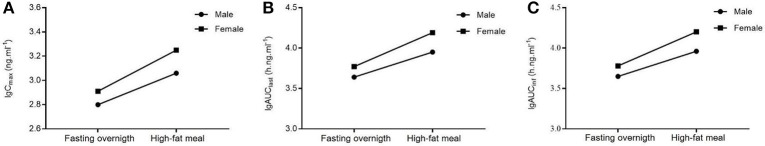
Interaction plots for Cmax
(A), AUClast
(B), and AUCinf
(C) vs. food and sex.